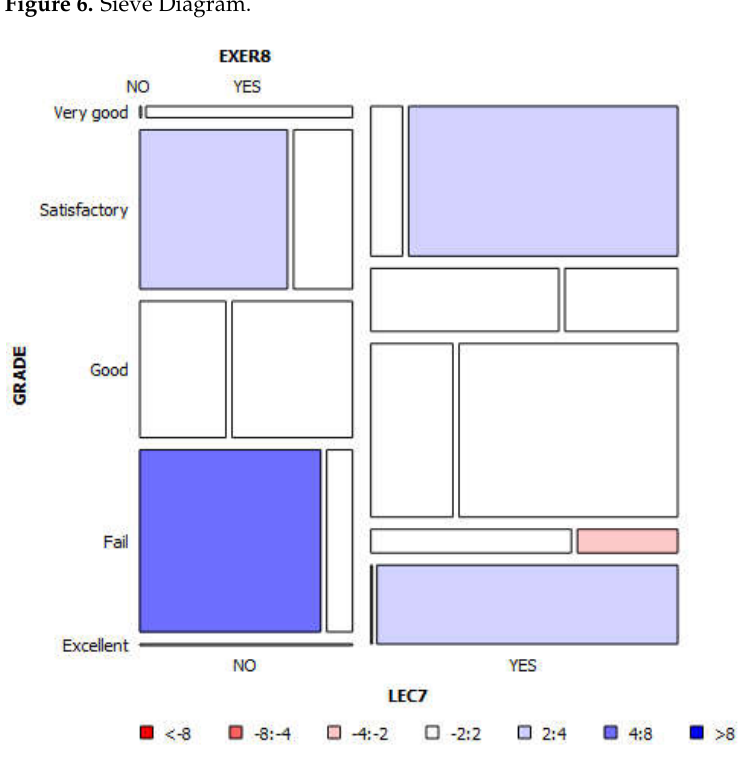
Figure 6. Sieve Diagram.